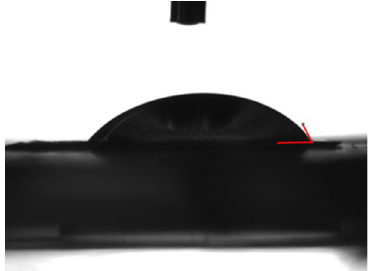
Figure 5. Water contact angle of the gelatin sponge (GS). Macroscopic image. Additionally, 1 μL of water was added dropwise to the GS.